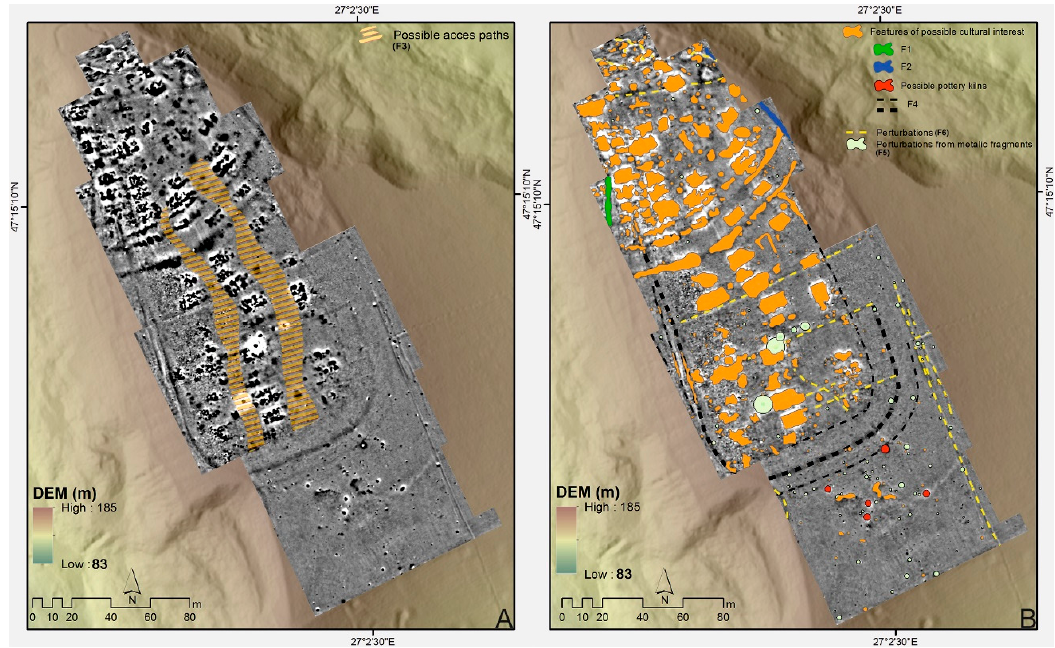
Figure 13. Interpreting the fluxgate data: ( A ) Fluxgate gradiometer survey ( − 10 to +10, white to black); ( B ) Identified structures.